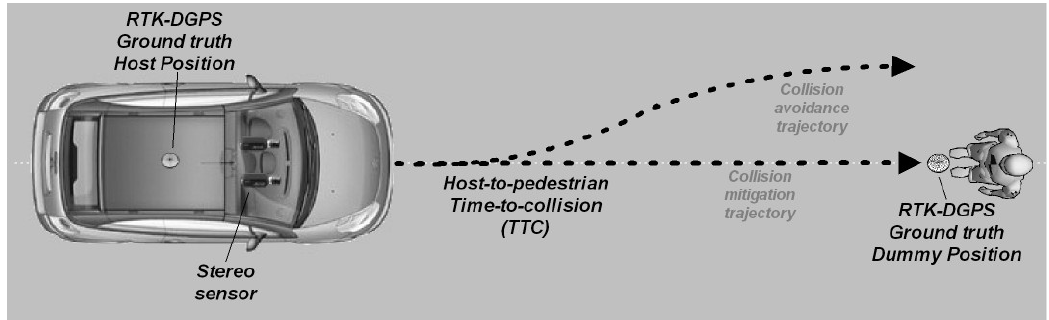
Figure 10. Experimental setup. The RTK-DGPS is used as ground truth data from both pedestrian position and vehicle position. The stereo sensor provides host-to-pedestrian sTTC